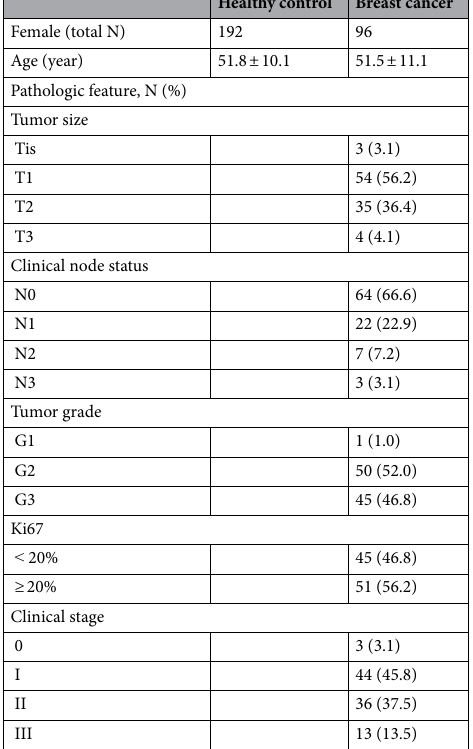
Table 2. Patient